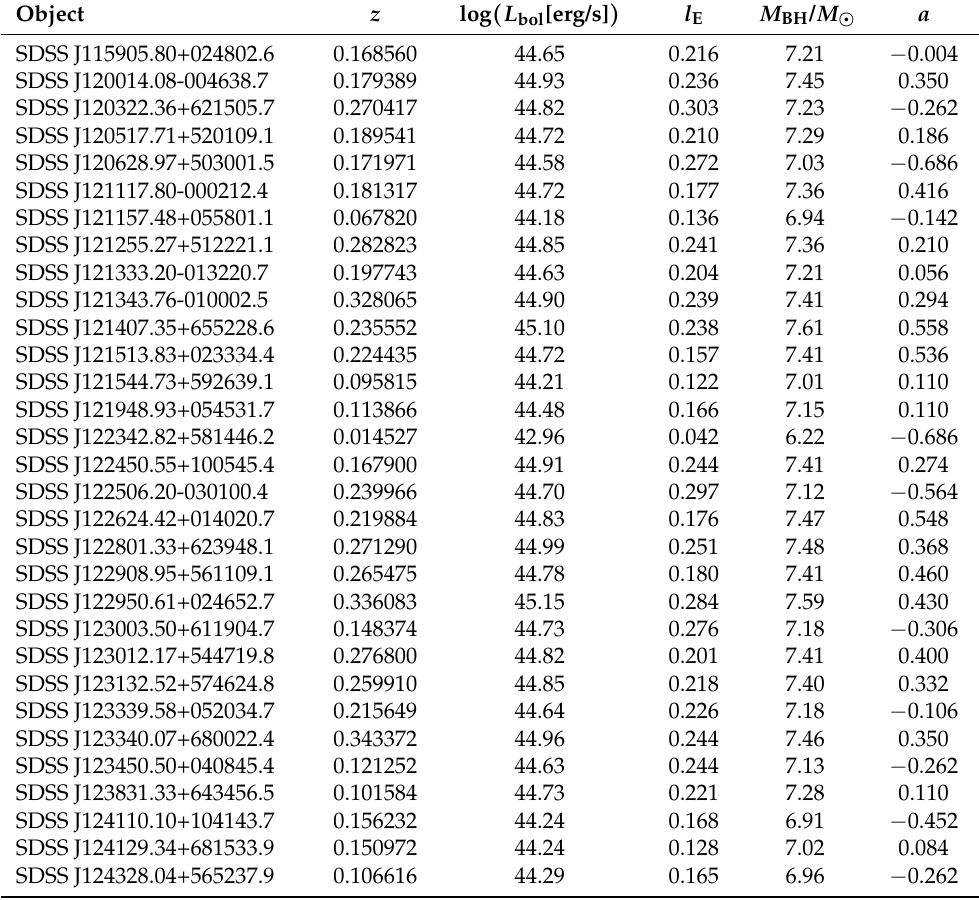
Table A5. All objects with their estimated spin values. Part 5 of